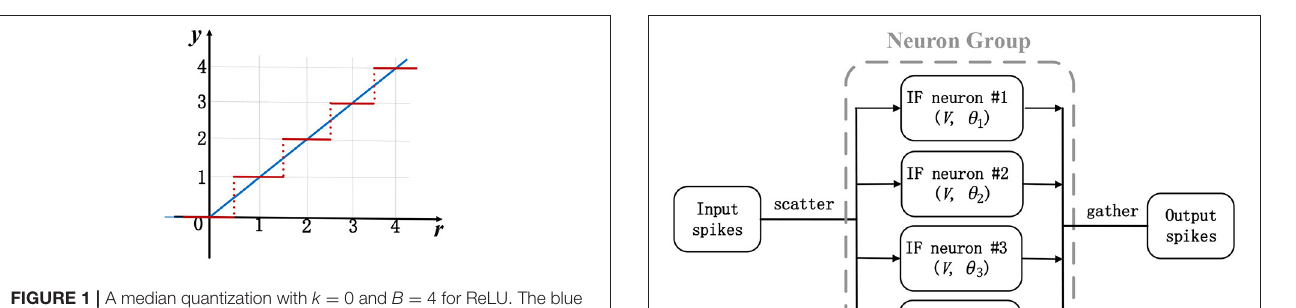
FIGURE 1 | A median quantization with k = 0 and B = 4 for ReLU. The blue line shows original ReLU function and the red line for the quantized ReLU.